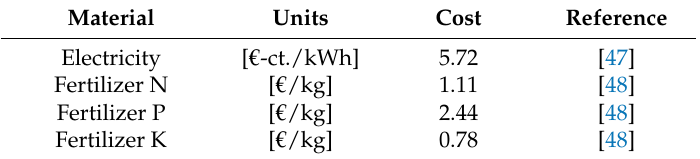
Table A7. Specific costs of selected production means required for feedstock production.